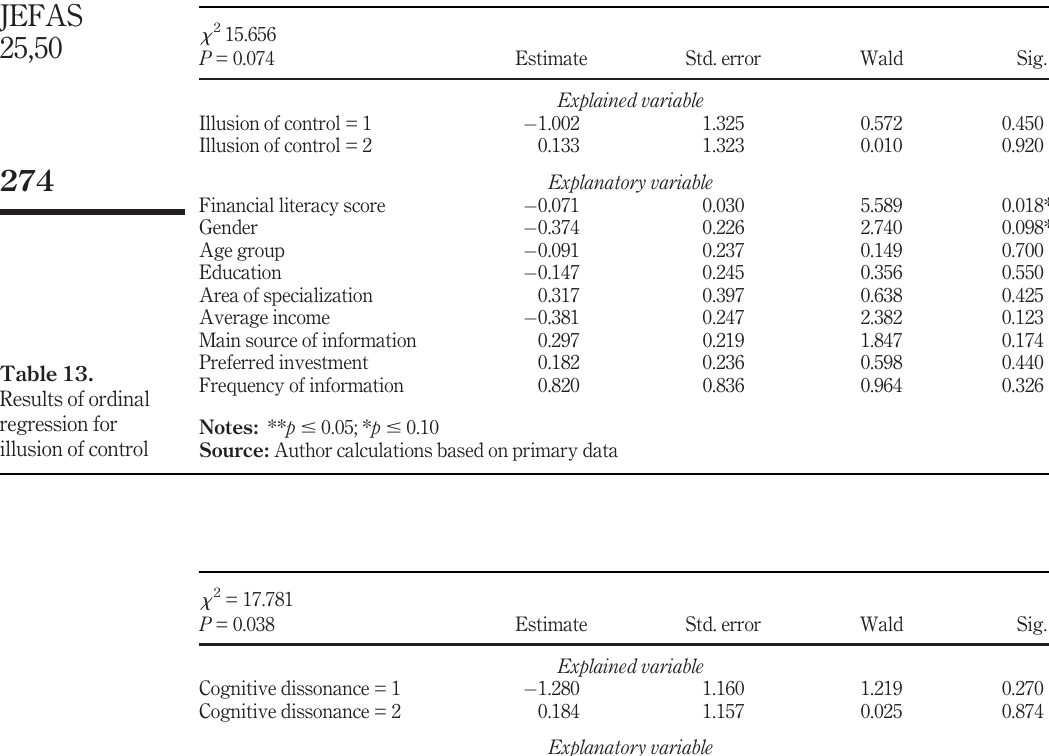
Table 14. Results of ordinal regression for cognitive dissonance